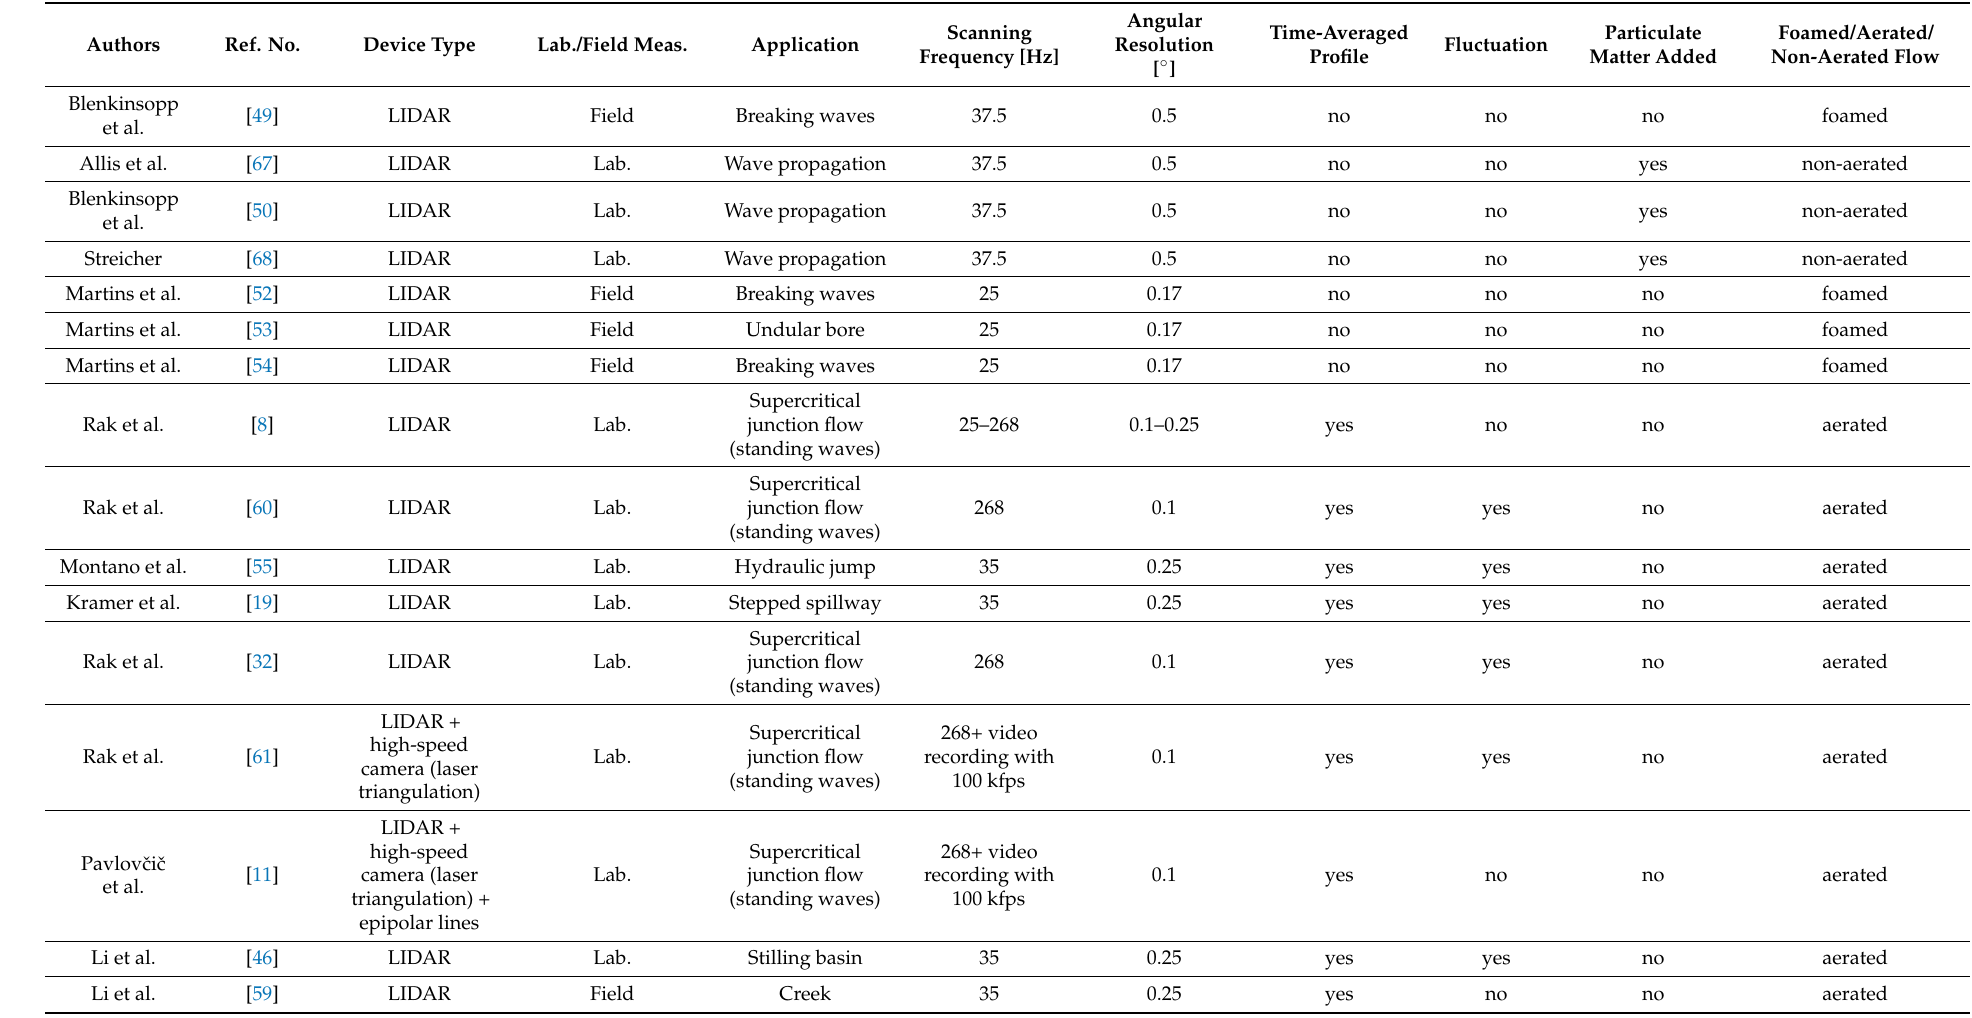
Table 2. Overview of studies using LIDAR and triangulation for free-surface